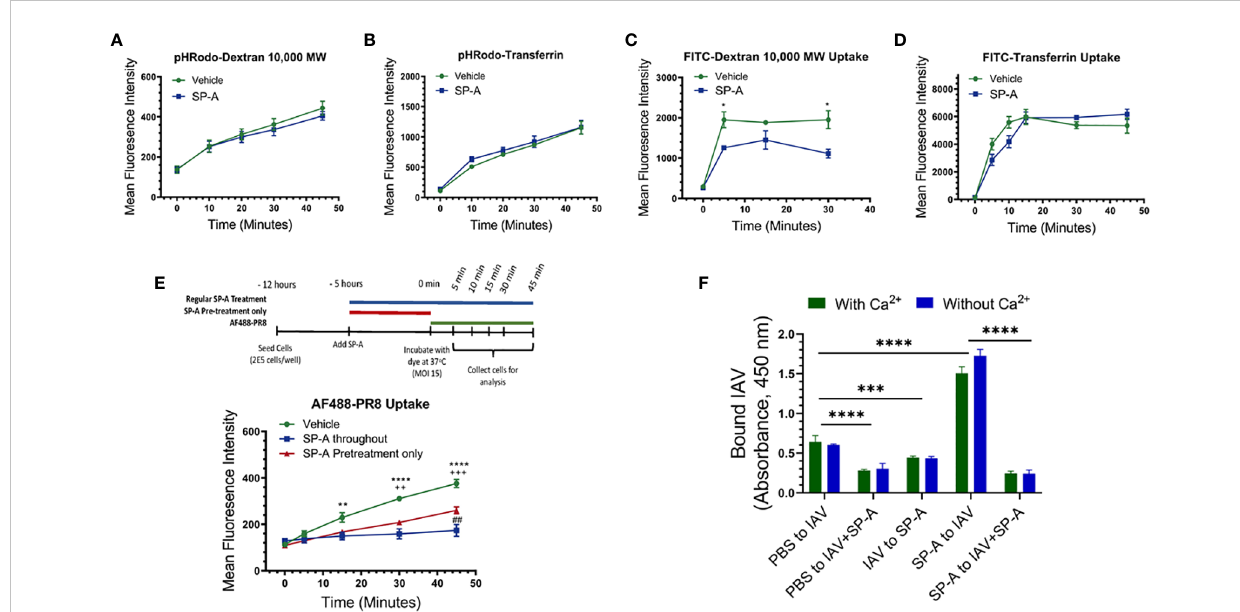
FIGURE 4 Differential reduction in uptake of endocytic cargo and binding of IAV PR8 to cell membrane in the presence of SP-A. Endocytic and binding experiments were performed using RAW264.7 cells (A-E) or isolated RAW264.7 membrane (F) . Raw264.7 cells were incubated with Dextran 10,000 or transferrin conjugated with either the pH sensitive dye pHRodo (A, B) or FITC (C, D) in 1:1 DMEM in the presence or absence of SP-A, for 15 minutes at room temperature. The media were replaced with dye-free 1:1 DMEM and cells incubated with PHRodo- and FITC-labeled molecules were chased at 37°C for 10, 20, 30, and 45-minutes and 5, 10, 15, 30, and 45-minutes at 37°C to monitor rates of endosomal acidi fi cation and uptake, respectively. (A, B) SP-A does not alter acidi fi cation rate for either Dextran (A) or transferrin (B) tracked endosomes, N=6. (C) SP-A reduced level of FITC-Dextran over the fi rst 5-minutes, whereas SP-A appeared to delay uptake of FITC-transferrin between 5-20-minutes reaching a similar plateau after 30-minutes. Differences were signi fi cant for FITC-Dextran only. N=6, *p<0.05. (D) and (E) SP-A suppresses uptake rate of Alexa Fluor488-labeled PR8. RAW264.7 cells were incubated with IAV with SP-A throughout infection or pre-treatment only. Cells were infected with Alexa Fluor488-labeled PR8 at MOI=15. The uptake of the labeled virus was monitored for 5, 15, 30, and 45-minutes at 37°C by fl ow cytometry. N=6 per condition per time point, **p < 0.005 and ****p < 0.001 for vehicle vs SP-A throughout; ++, p < 0.005 and +++, p<0.0005 for vehicle vs SP-A pretreatment; ## , p < 0.05 for SP-A throughout vs SP-A. (F) To assess differences in membrane binding, immulon-2 fl at bottom plates were coated overnight at 4°C with 12.5 m g/ml of Raw264.7 cell membranes and then washed and incubated with PBS, 5 x 10 6 ffc of PR8, or 50 m g/ml SP-A for 2- hours at room temperature. The membranes were then washed, and incubated for an additional 2-hours with PR8, pre-formed PR8+SP-A complex, or SP-A to evaluate PR8 binding in a combination of conditions shown on the x-axis on panel F graph. Plates were washed and bound PR8 visualized spectrophotometrically using a polyclonal anti-HA antibody and HRP-conjugated anti-rabbit antibody as described in Materials and Methods. N=8, ****p < 0.00001, ***p < 0.001. Statistical differences were assessed by 2-way